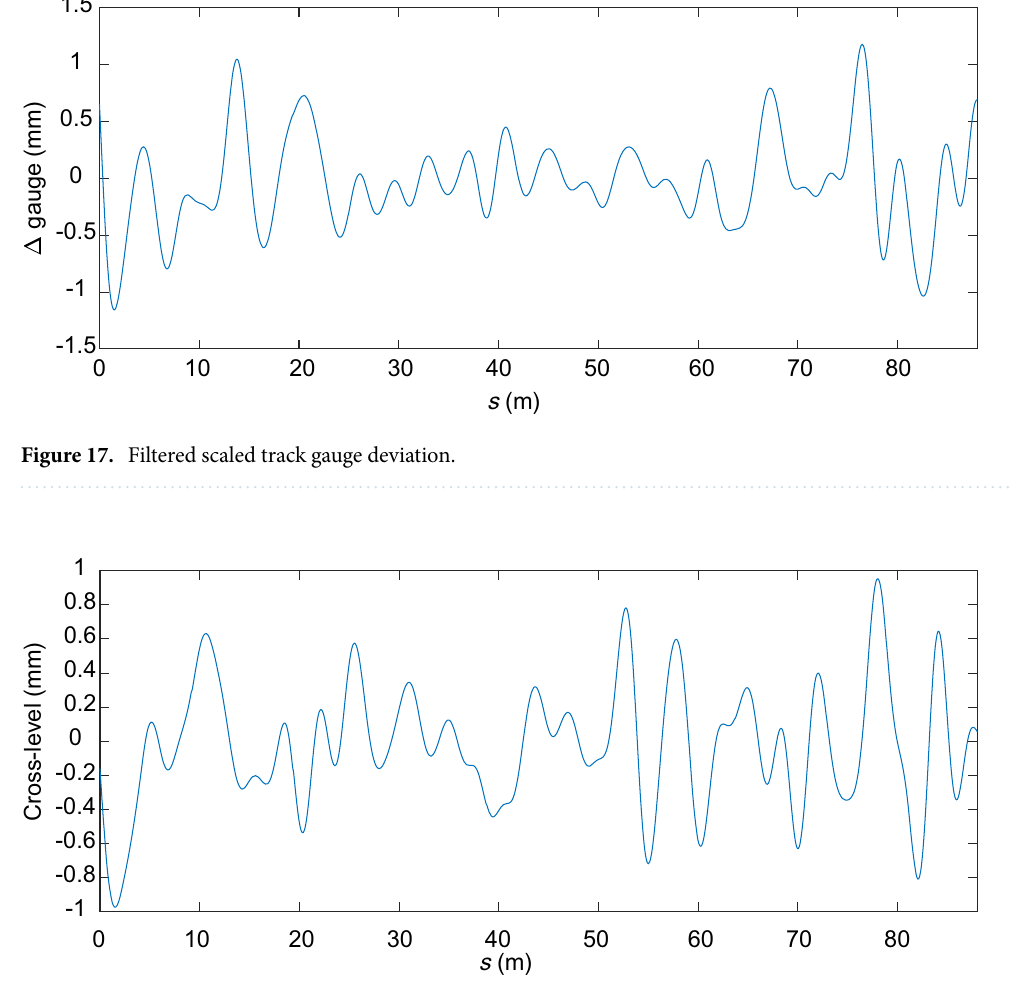
Figure 18. Filtered scaled track cross-level irregularity.